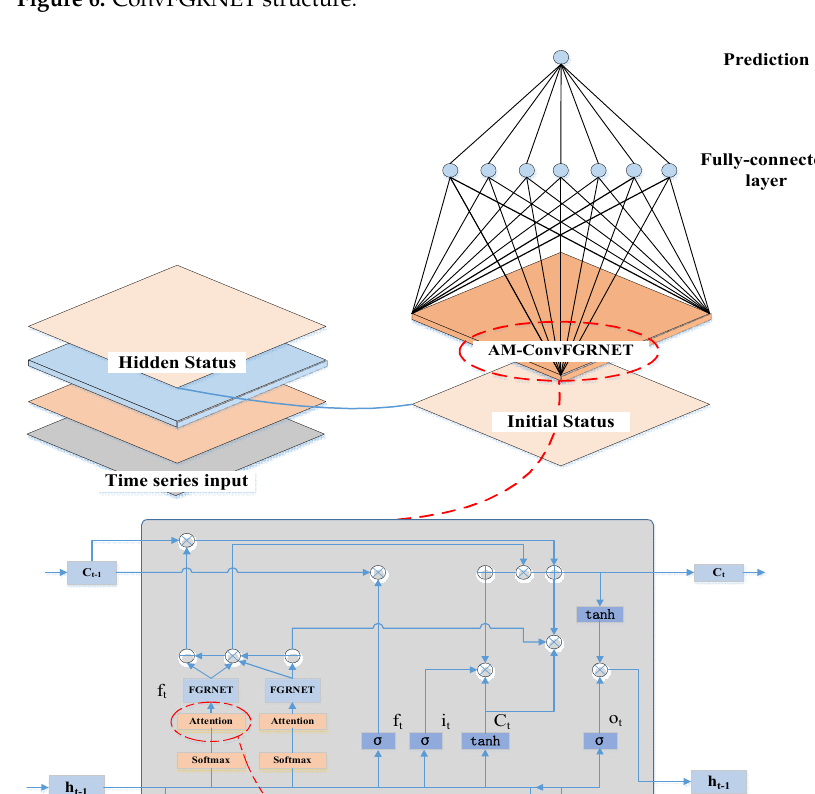
Figure 6. ConvFGRNET structure.